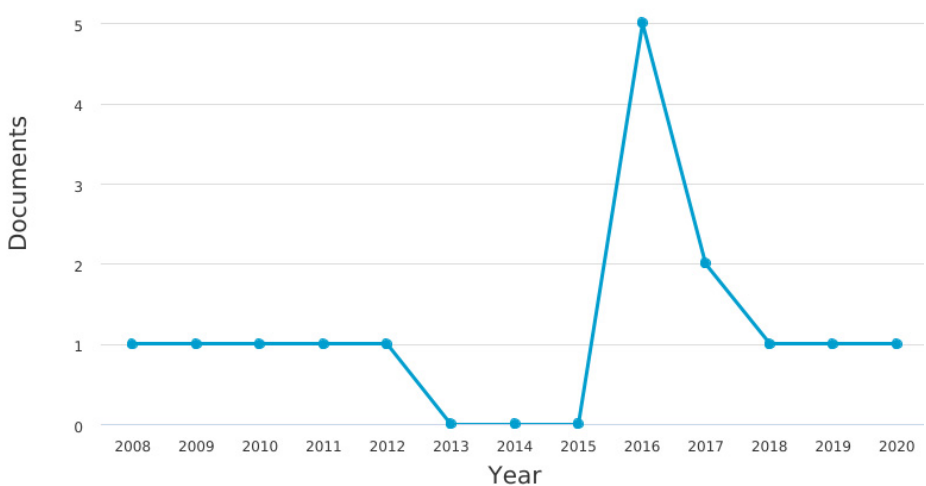
Figure 1. Number of publications on postoperative pain over the years. Twenty-three countries were cited in the authors’ affiliations section of the 15 pub- lications included in this review. Many of the selected articles had contributions from authors from developed countries. Among them, the United States leads in a number of participations. The countries that contributed with the largest number of studies were Nigeria (3 publications), India (2 publications) and Pakistan (2 publications) (Figure 2).